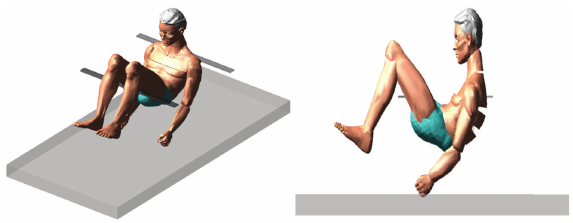
Figure 5: A fall from the lifting arms due to the narrow width.